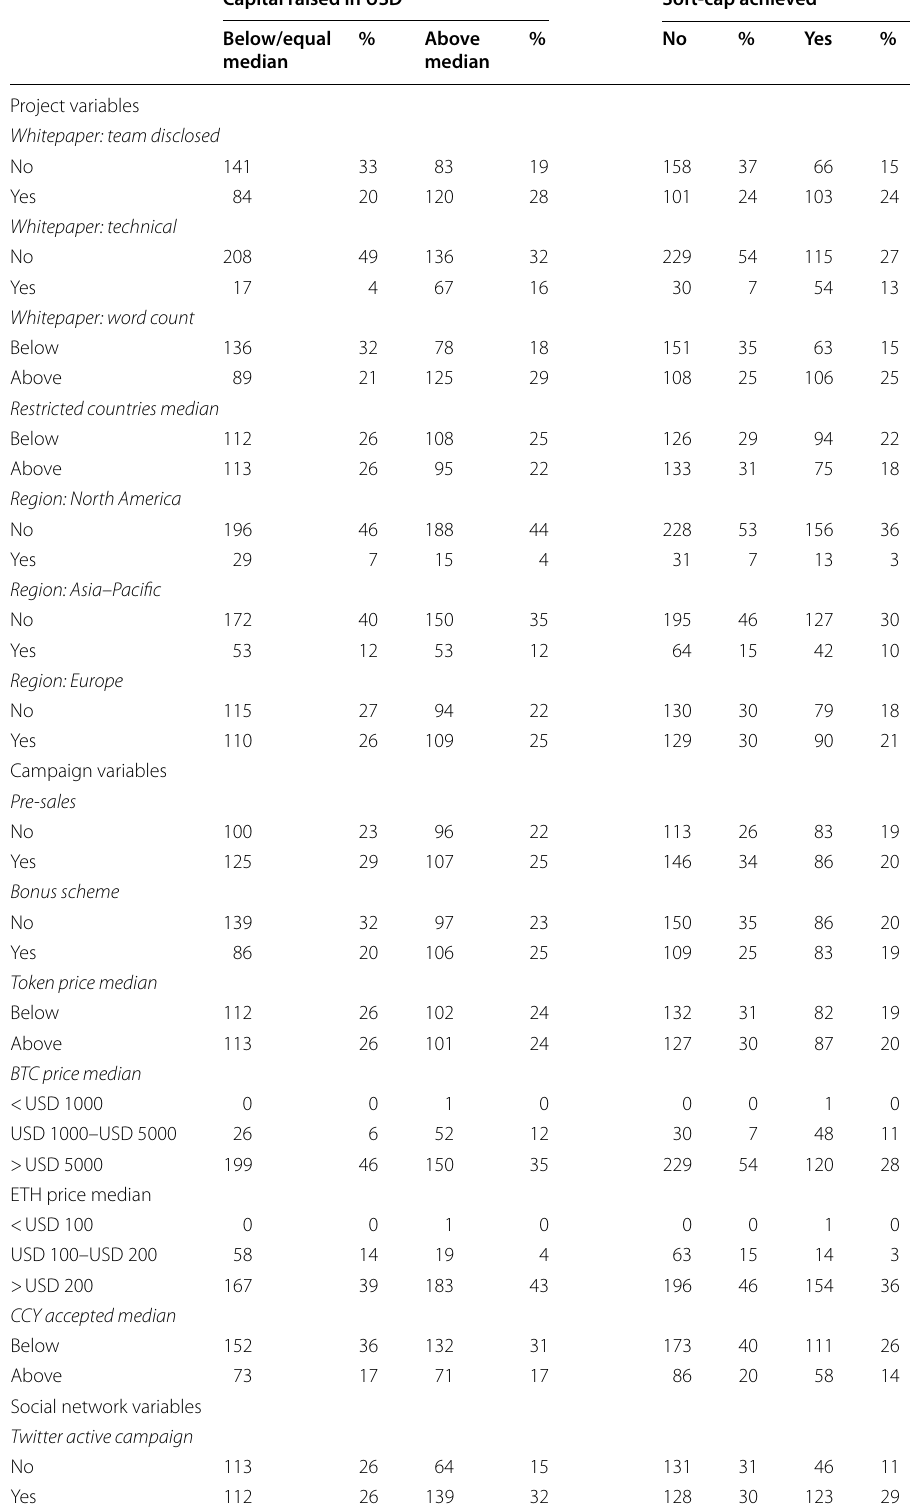
Table 2 Cross table between dependent and independent variables Capital raised in